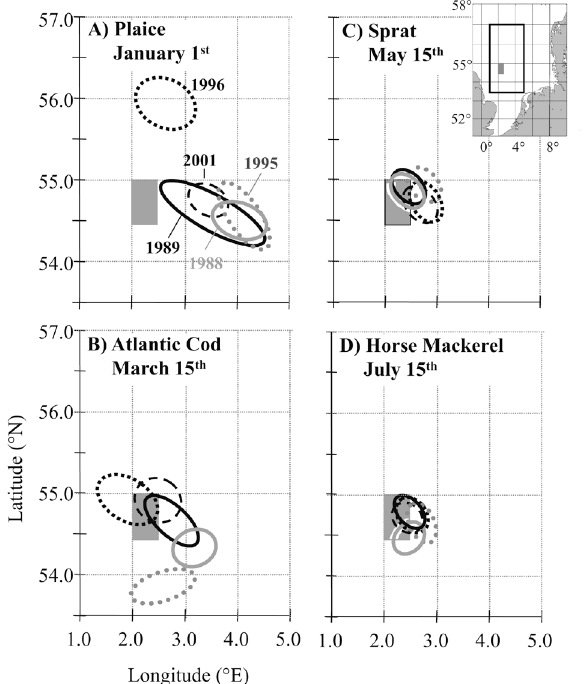
(C) and horse mackerel (D) on Dogger Bank (insert map provided). The results for five different years are shown in each